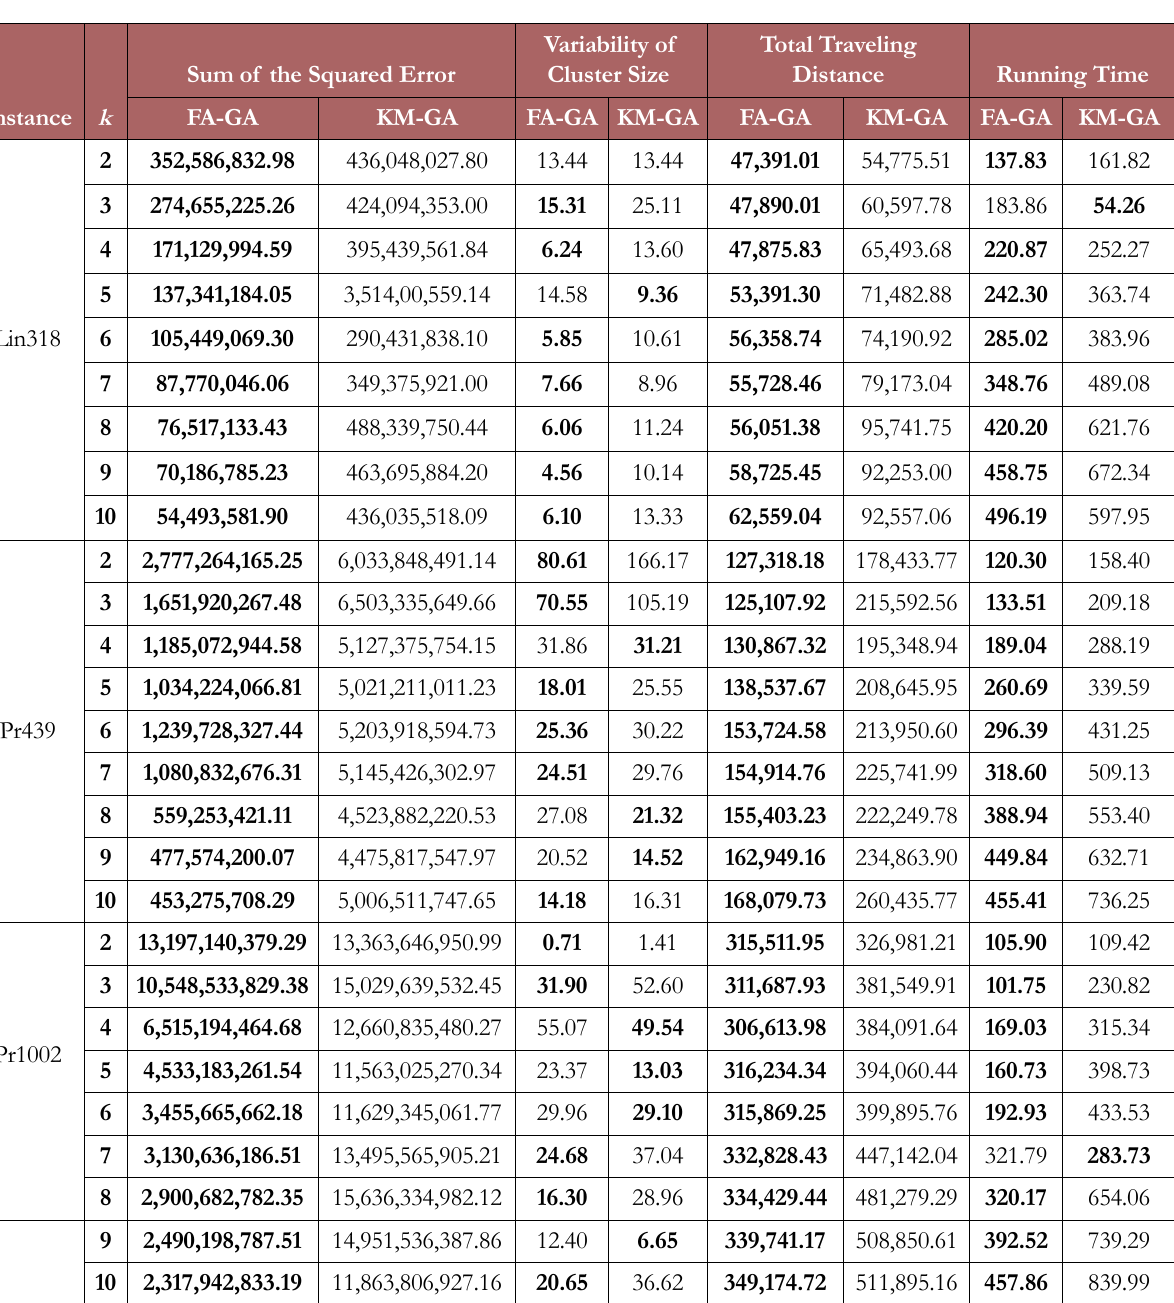
Table A-1. Performance evaluation